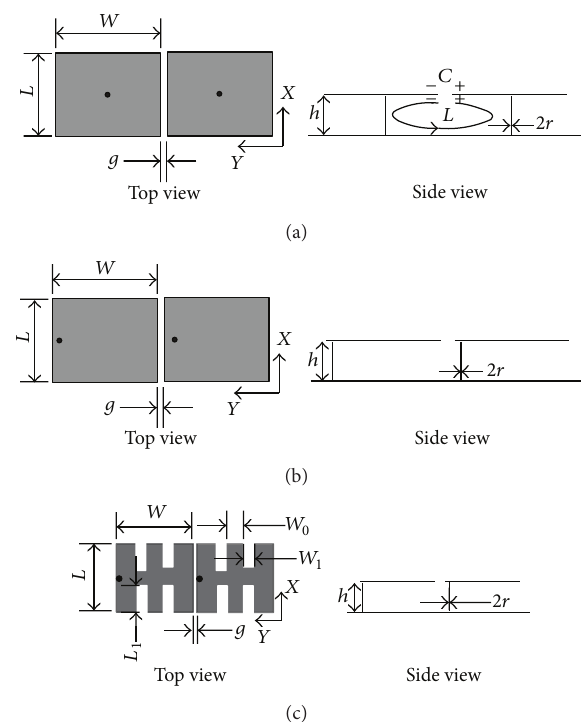
Figure 1: Geometries of the EBG. (a) CMT-EBG, (b) ELV-EBG, and (c)